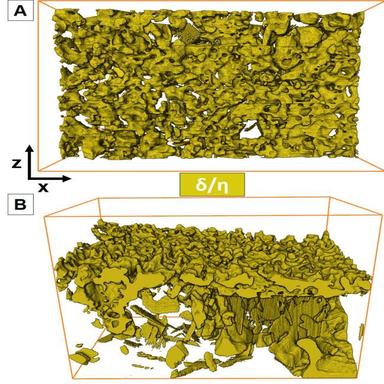
3D tomographic reconstruction of the δ and η phases: A) top view; B) perspective view.